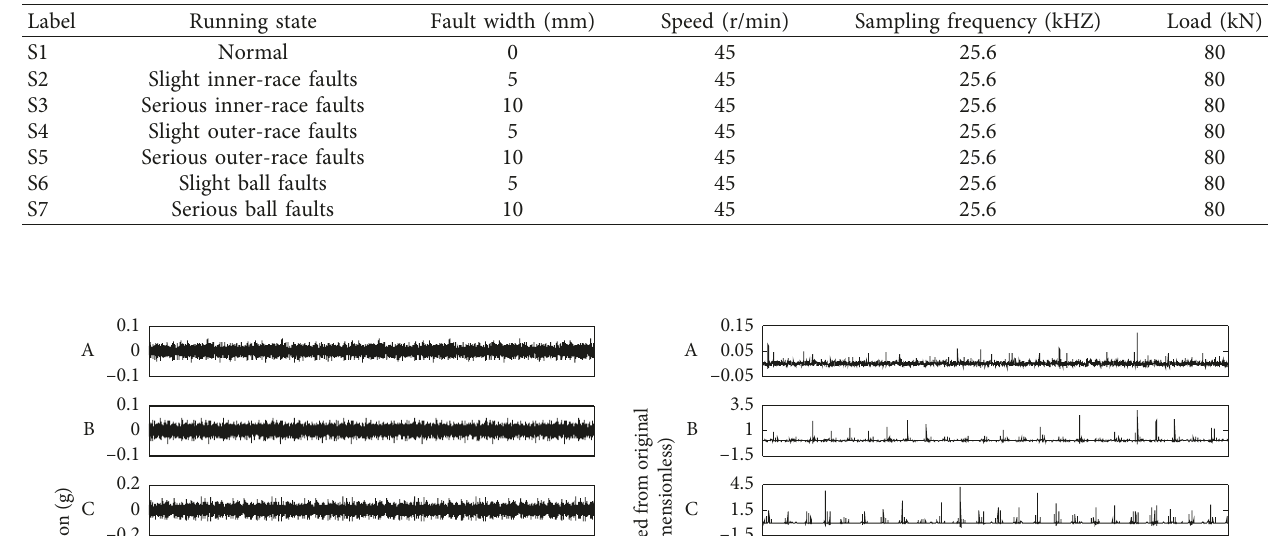
Figure 8: Artificial faults on the components of the axle box bearing: (a) normal; (b) slight outer-race faults; (c) serious outer-race faults; (d) slight inner-race faults; (e) serious inner-race faults; (f) slight ball faults; (g) serious ball faults. Table 2: The detail descriptions of seven vibration acceleration signals.